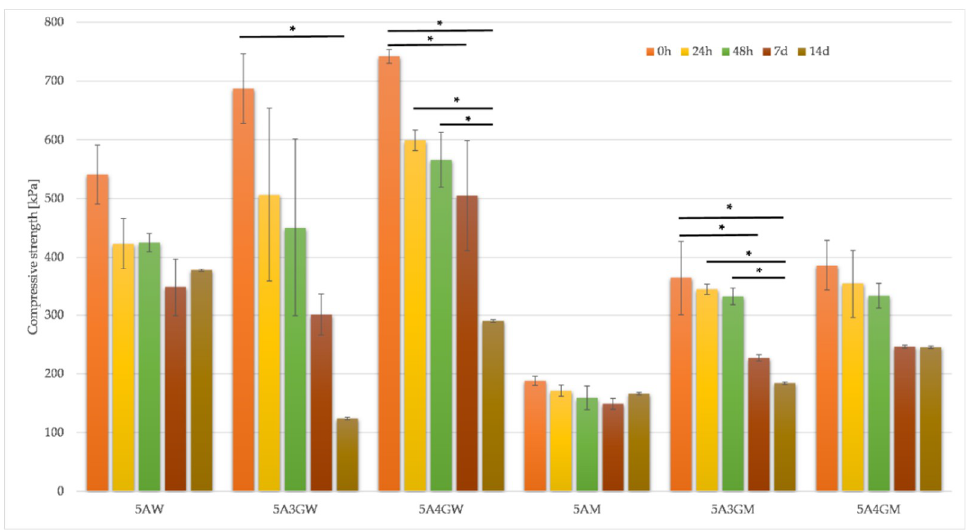
Figure 4. Compressive strength results for samples dissolved in water (W) and full culture medium (M) with different content of gelatine evaluated after 24 h, 48 h, 7 days, and 14 days of incubation (* = p < 0.05, results statistically significant).